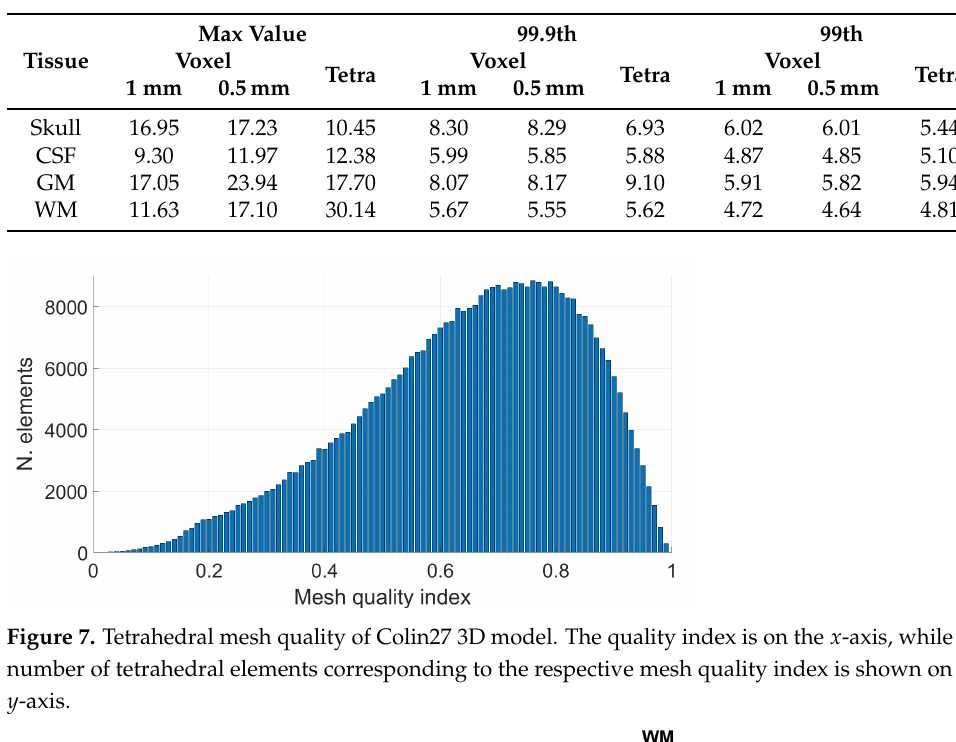
Table 6. Deviation of the E -field in the localized case—all values are expressed in mV/m.